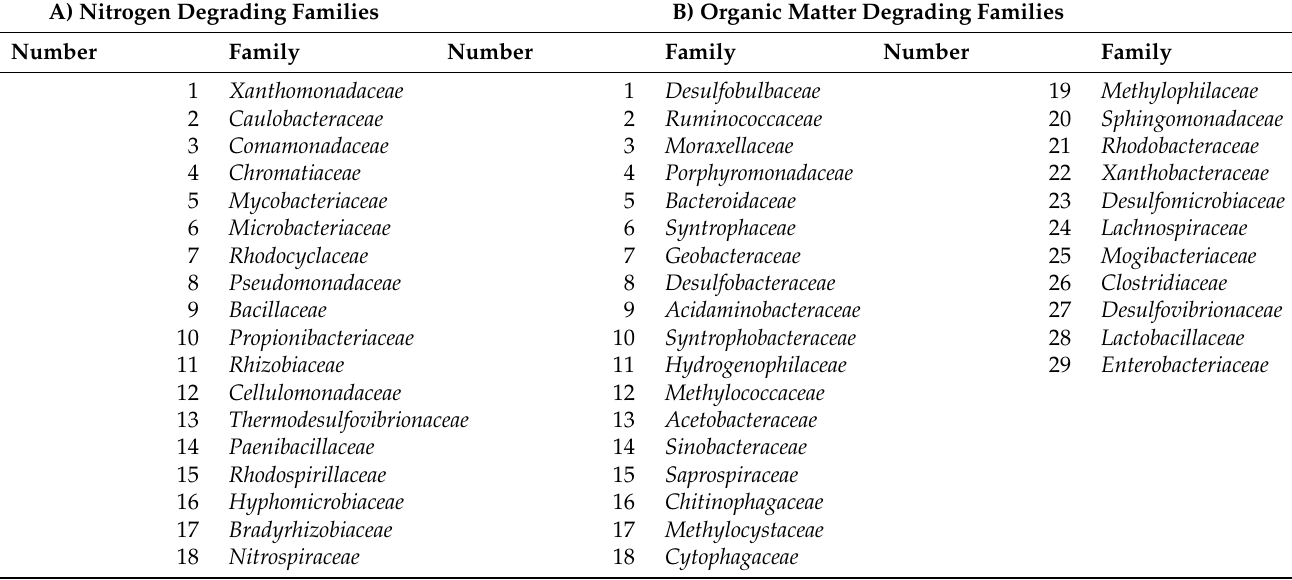
Table 2. Numbers assigned to bacterial